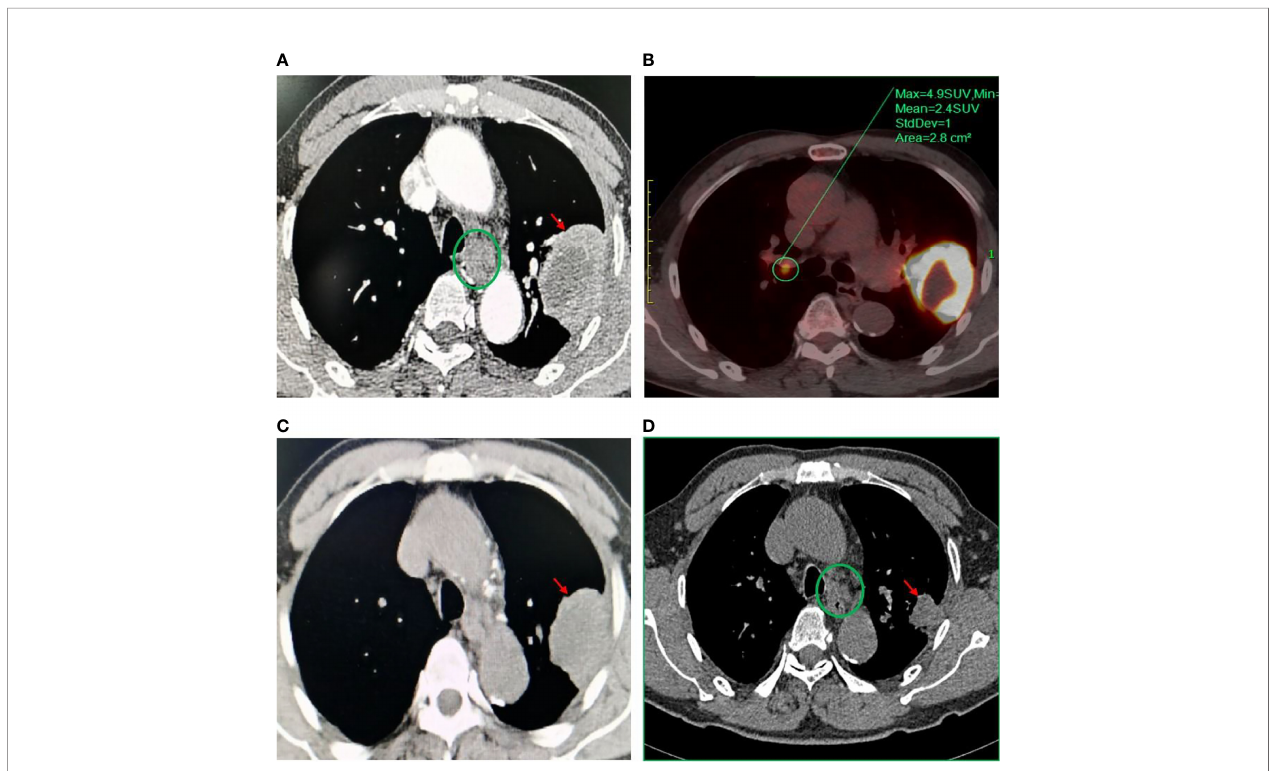
FIGURE 1 | Disease status before and after neoadjuvant chemotherapy and aumolertinib treatment. Computed tomography chest (CT) scan showed (A) pulmonary nodule in the left upper lobe of the lung, size 7.8 × 4.9 cm before chemotherapy. PET/CT showed (B) lymph node enlargement in the right hilar and pulmonary nodule in the left upper lobe before chemotherapy. (C) Stable disease (SD) based on imaging fi ndings after 2 cycles of chemotherapy. (D) Pulmonary nodule in the left upper lobe of the lung, size 2.2 × 2.0× 1.8 cm after almost 2 months of aumolertinib treatment, with tumor remission reaching partial remission